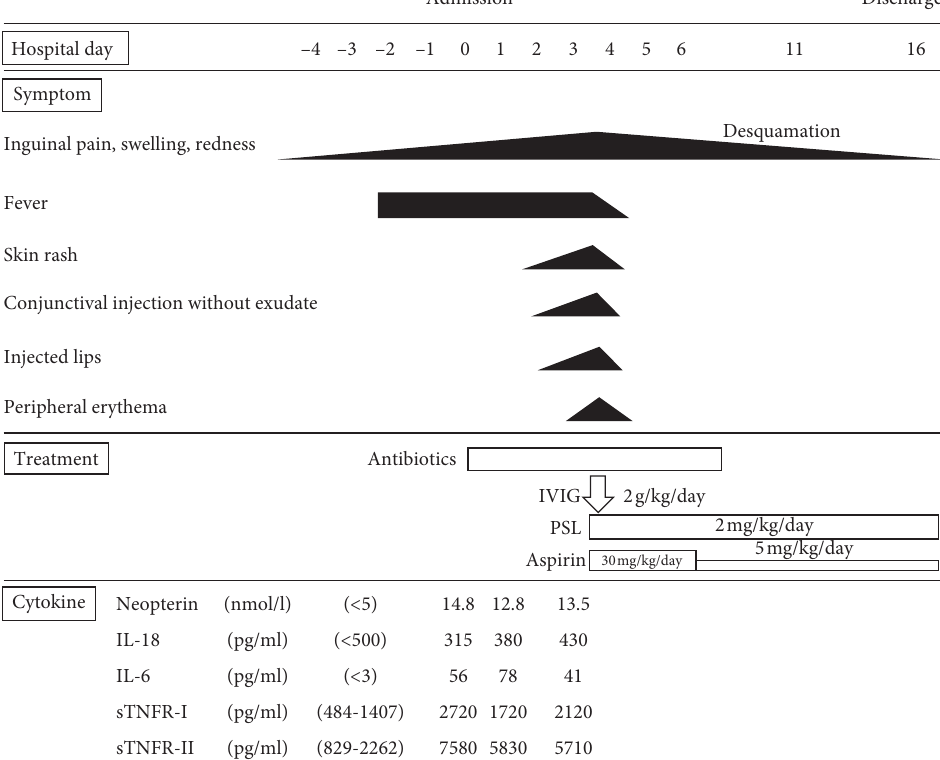
Figure 2: Clinical course. IL, interleukin; IVIG, intravenous immunoglobulin; PSL, prednisolone; sTNFR, soluble tumor necrosis factor receptor.